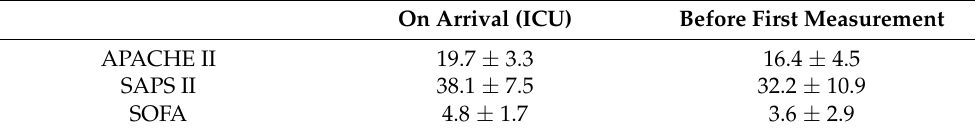
Table 2. Scores of patient condition and clinical